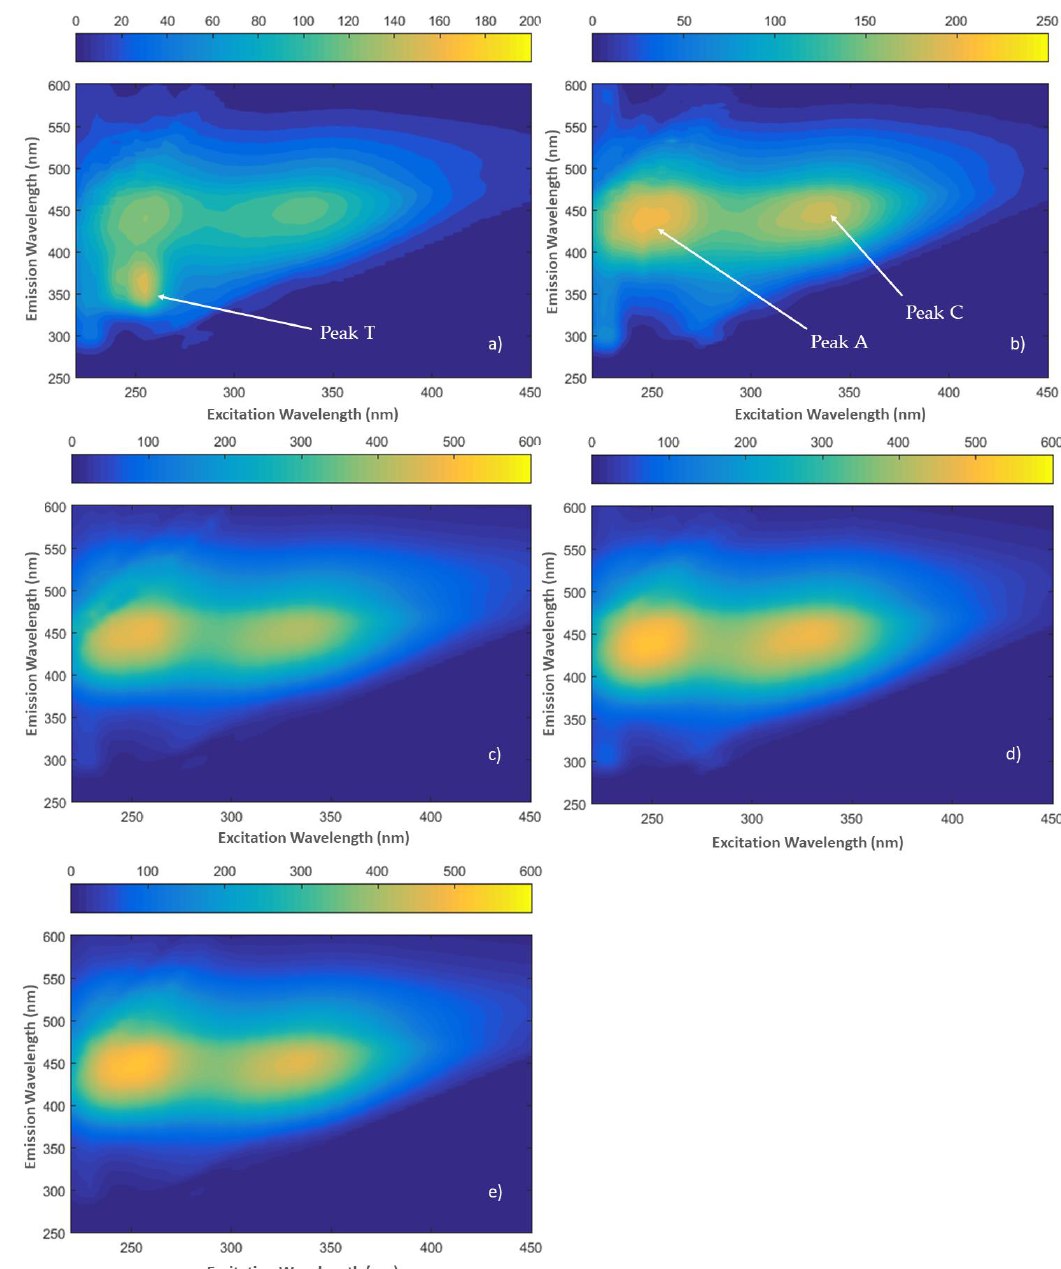
Figure 3. Fluorescence excitation–emission matrices (EEMs) of SAS DOM samples after acidification; ( a ) SAS 1A surface; ( b ) SAS 1A bottom; ( c ) SAS 2A surface; ( d ) SAS 2A bottom; ( e ) SAS 1B mid-water column.